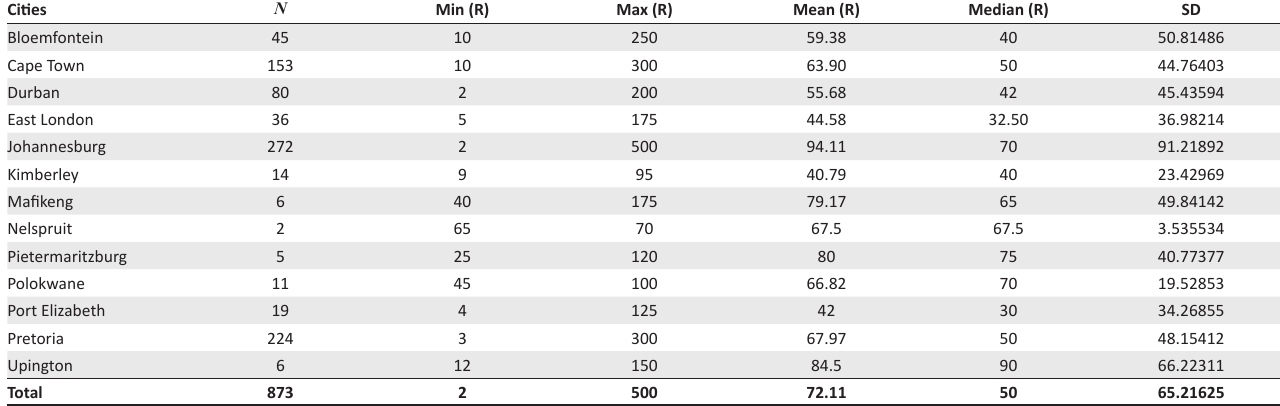
TABLE 1: Minimum, maximum, mean and median incomes usually earned for a day’s waste in the different cities ( n = 873). Cities N Min (R) Max (R) Mean (R) Median (R) SD Bloemfontein 45